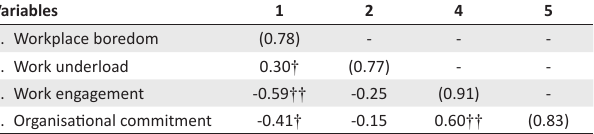
TABLE 3: Correlation matrix for the latent